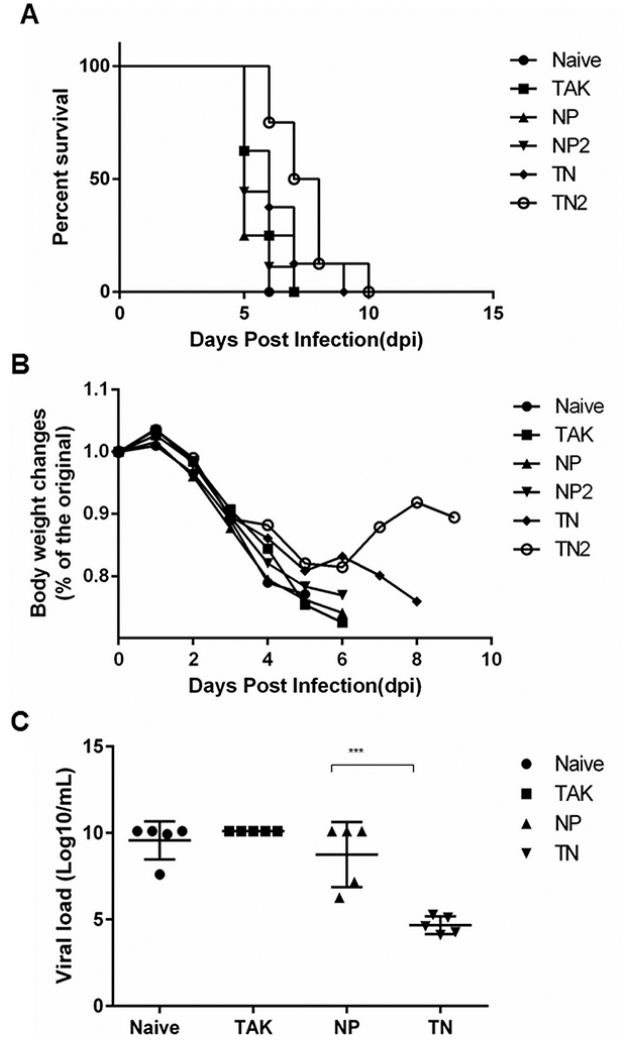
Figure 8. Protection efficacies of mice immunized with NP with or without TAK-779 treat- ment against lethal H1N1 influenza A virus challenge Mice were immunized once or twice with NP and treated with or without TAK-779 as scheduled. Two weeks after TAK-779 ces- sation, mice were challenged with 10 LD50 of H1N1 (A/FM/1/47). The survival rates (A) were compared with infected control mice (naïve and TAK groups). Body-weight changes (B) were monitored daily, and mice were euthanized when body weight loss exceeded 25% of original body weight. (C) Viral load quantification in the lungs of control mice and mice immunized twice with NP and treated with or without TAK-779. Mice were immunized twice with NP and treated with or without TAK-779 as scheduled. Two weeks after TAK-779 cessation, mice were challenged with 10 LD50 of H1N1 (A/FM/1/47). At 3 d post–viral chal- lenge, the viral loads were measured in the lungs of different groups of mice by TCID50 assay. Each symbol represents an individual mouse, and the lines represent the geometric mean ± SD. Five animals per group per time point were assayed. *** p ≤